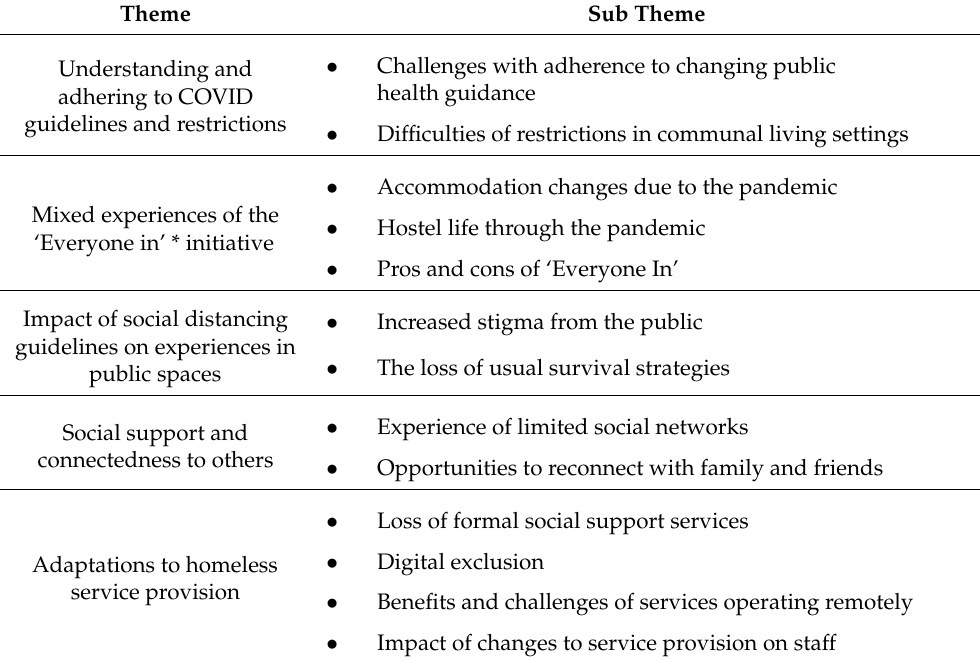
Table 3. Themes relating to the impact of the COVID-19 pandemic and associated restrictions on people experiencing